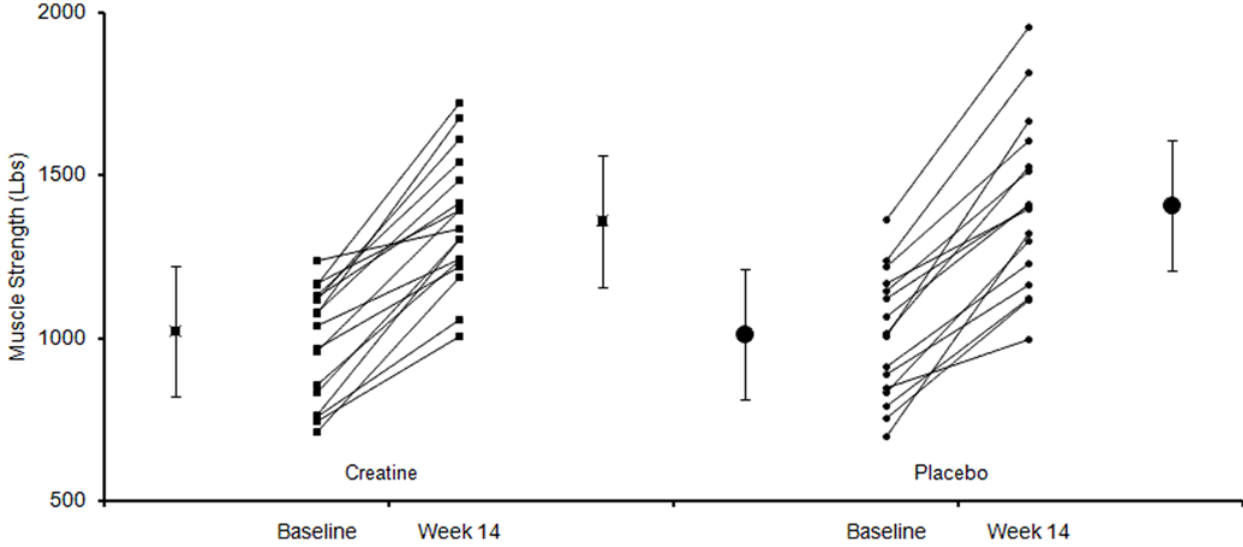
Figure 2. Muscle strength before and after 14 weeks of study. Large rectangles represent the average values, while smaller rectangles individual data before and after creatine supplementation. Similarly, large circles represent the average values, while smaller circles individual data before and after placebo supplementation. Data are the sum of strength (1 RM) in 8 muscle groups in subjects randomized to receive creatine monohydrate or placebo. Strength increased significantly within each treatment group (P , 0.01), but there was no significant difference between groups in the magnitude of the increase (average increase 44 and 42% (difference 2%, 95% CI 2 9.5% to 13.9%) in creatine and placebo, respectively,